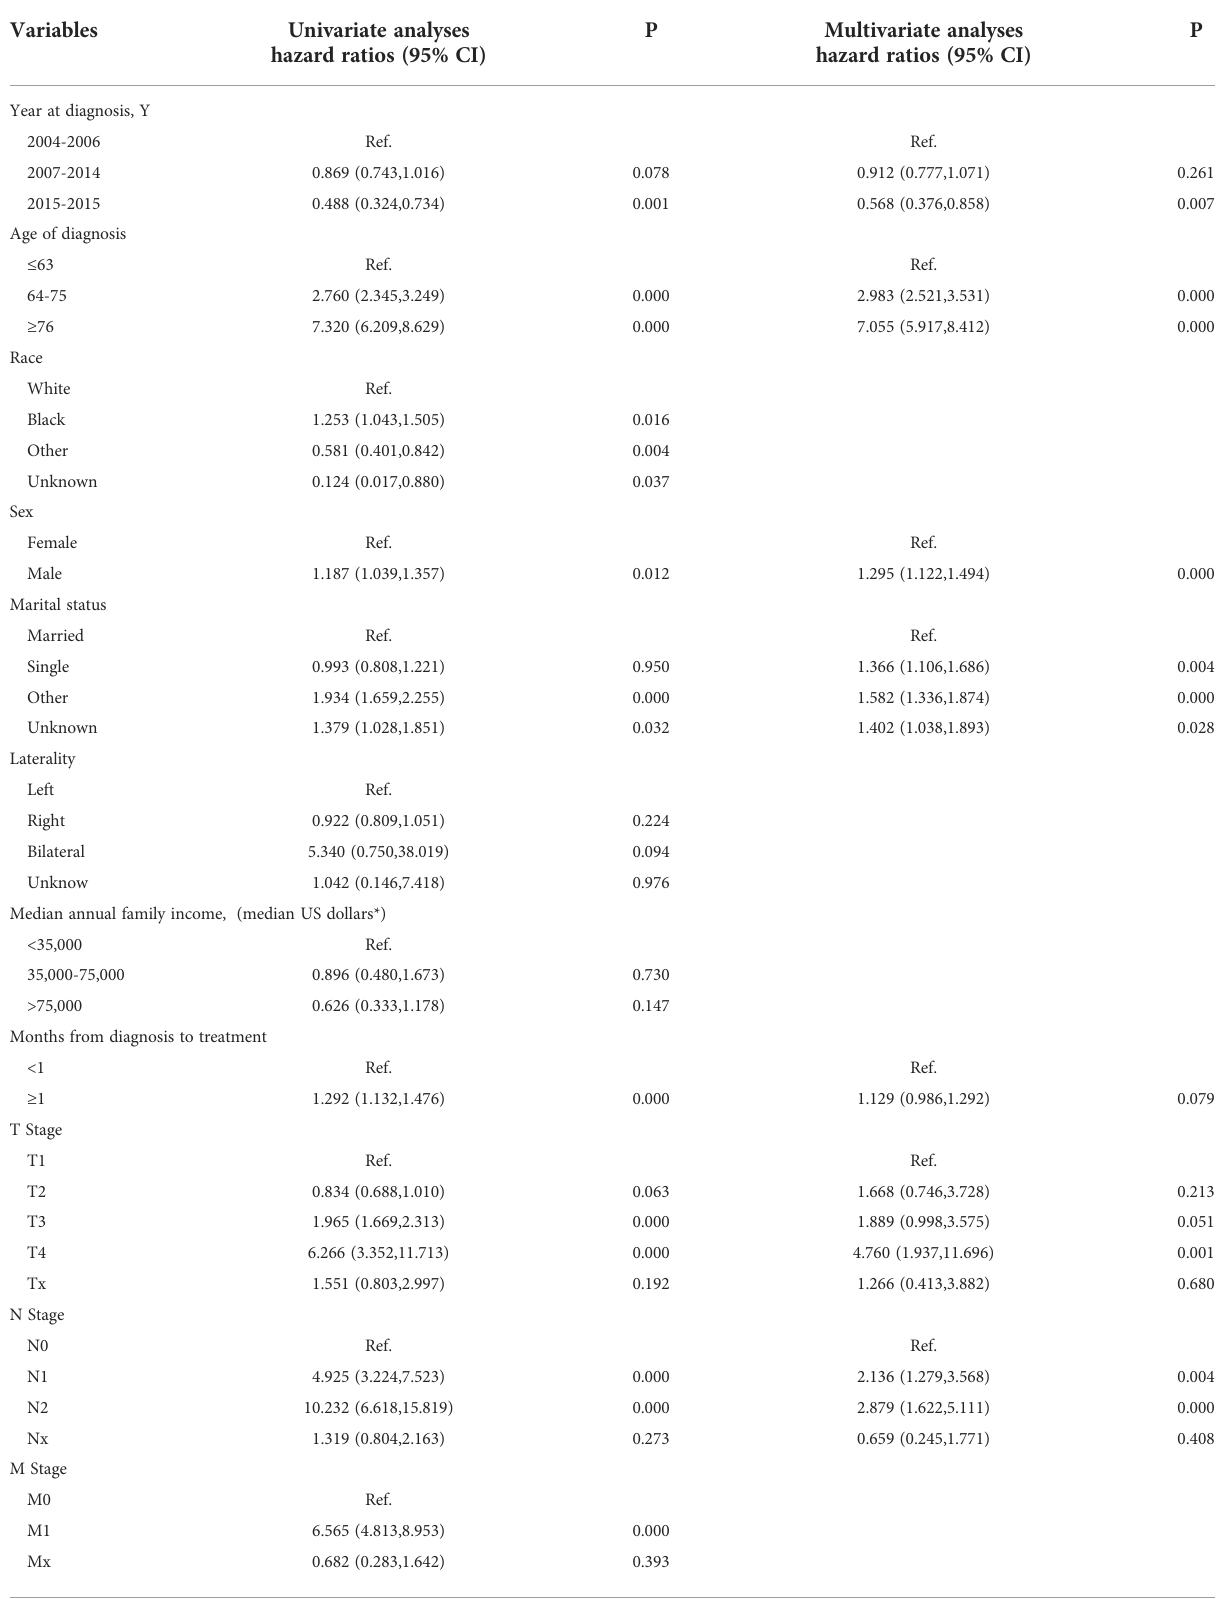
TABLE 3 Univariate and multivariate analyses of overall survival for training